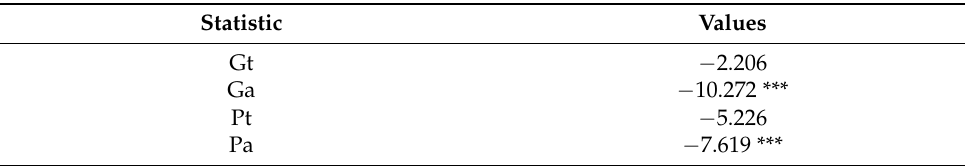
Table 5. Cointegration test.